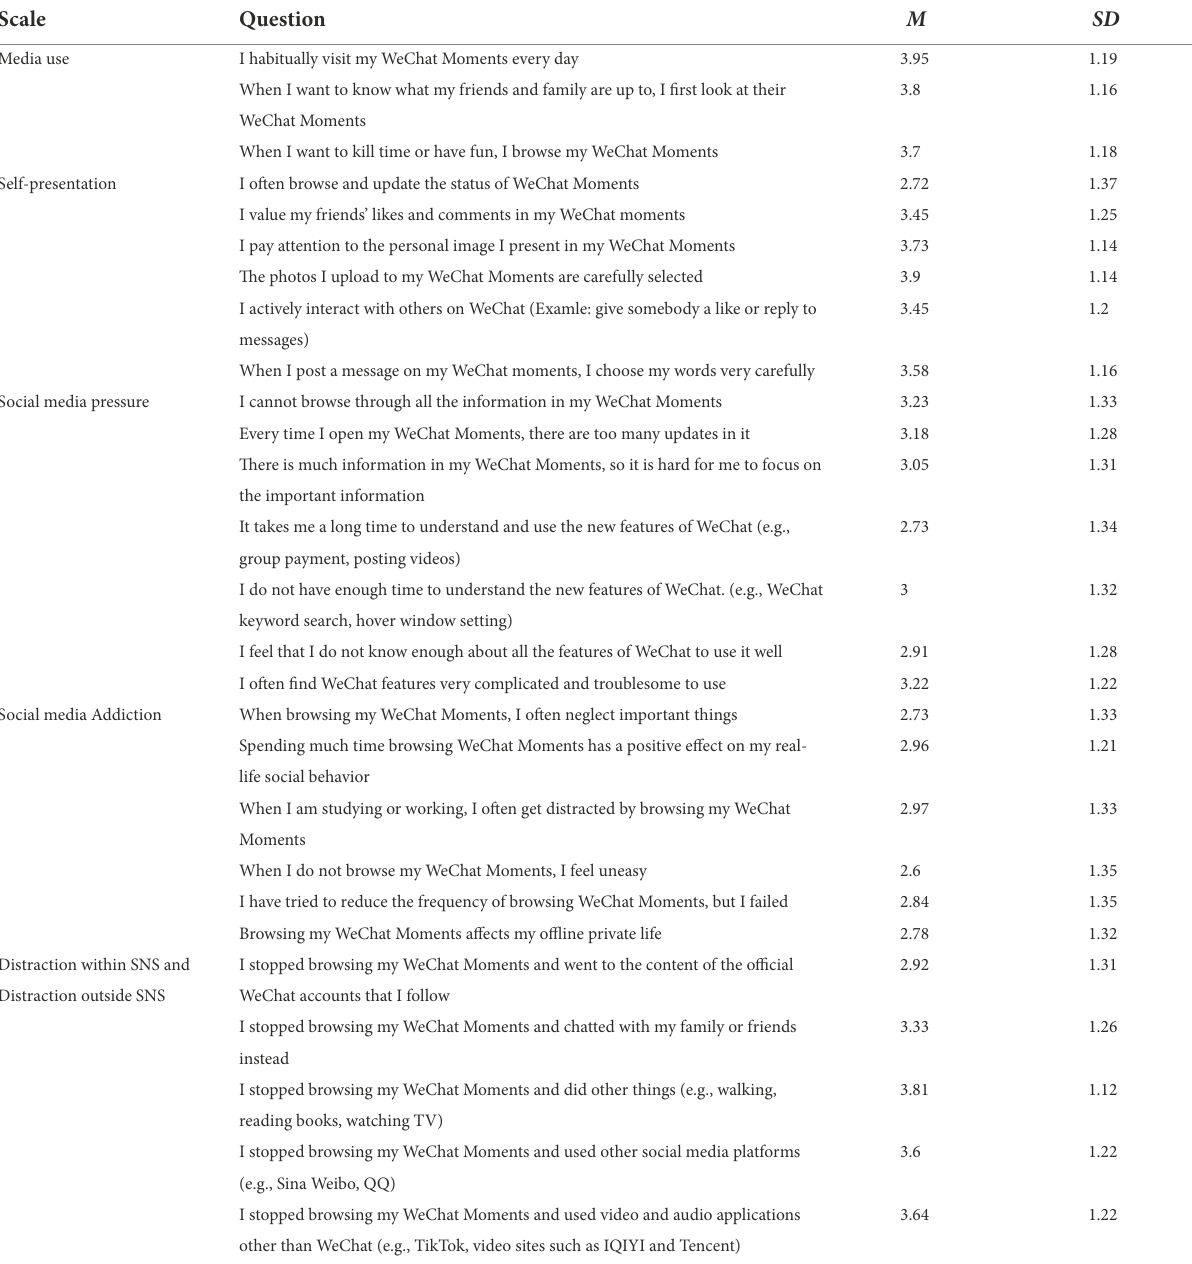
TABLE 4 Descriptive of the